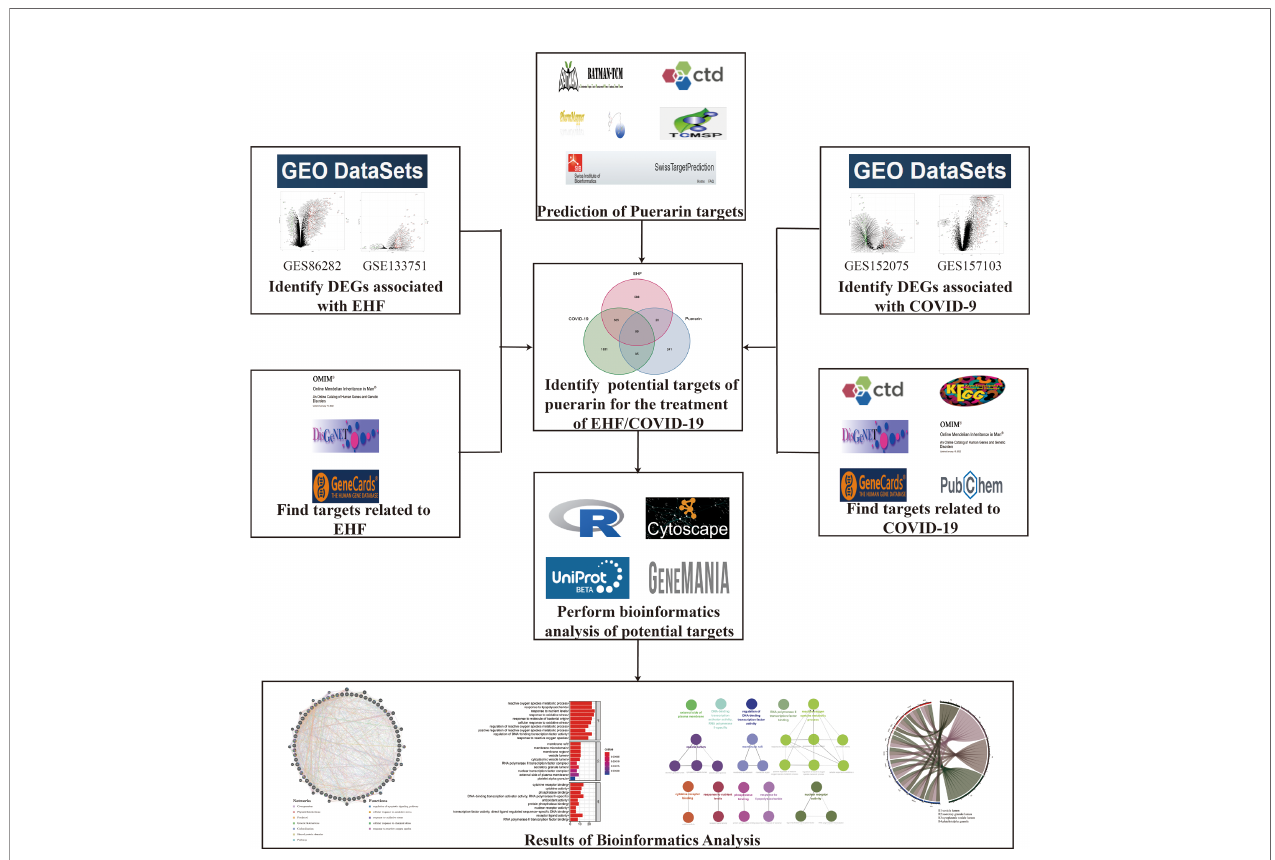
FIGURE 1 | Flowchart. This fi gure shows the speci fi c process to explore puerarin ’ s potential therapeutic effects and mechanisms in treating EHF/COVID-19 through network pharmacology and